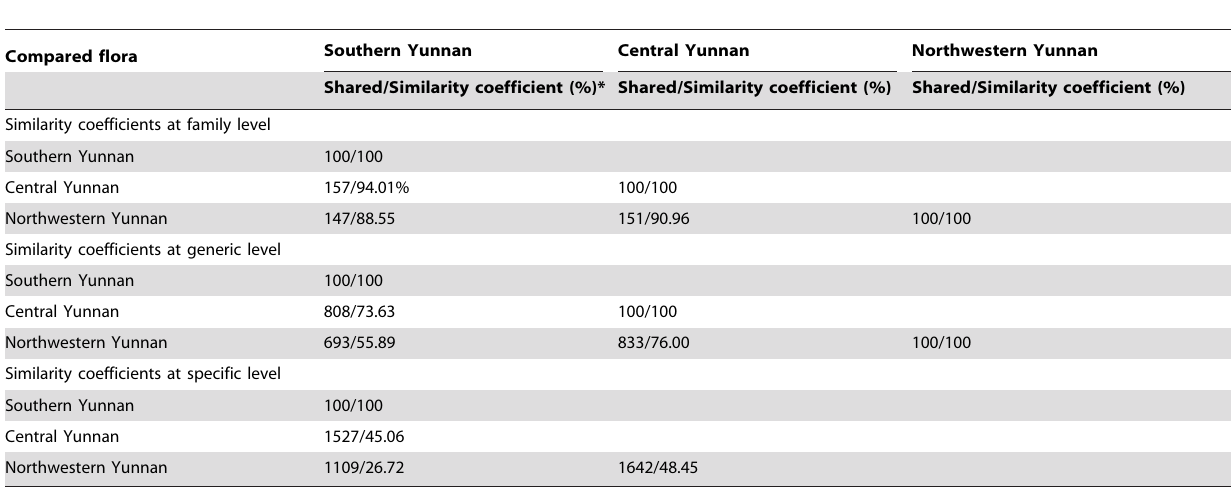
Table 5. Comparison of floristic similarities at the family, generic and specific levels between these floras of southern, centre and north-western Yunnan.